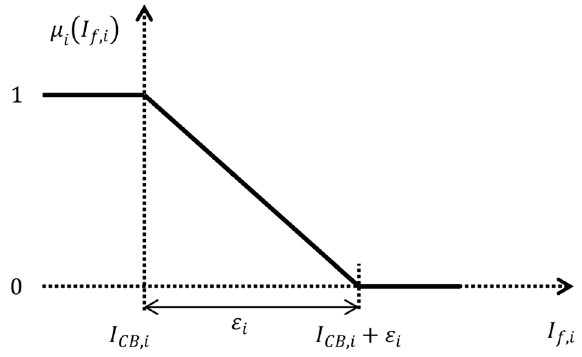
Figure 1. Triangular fuzzy membership function of a fault level constraint.